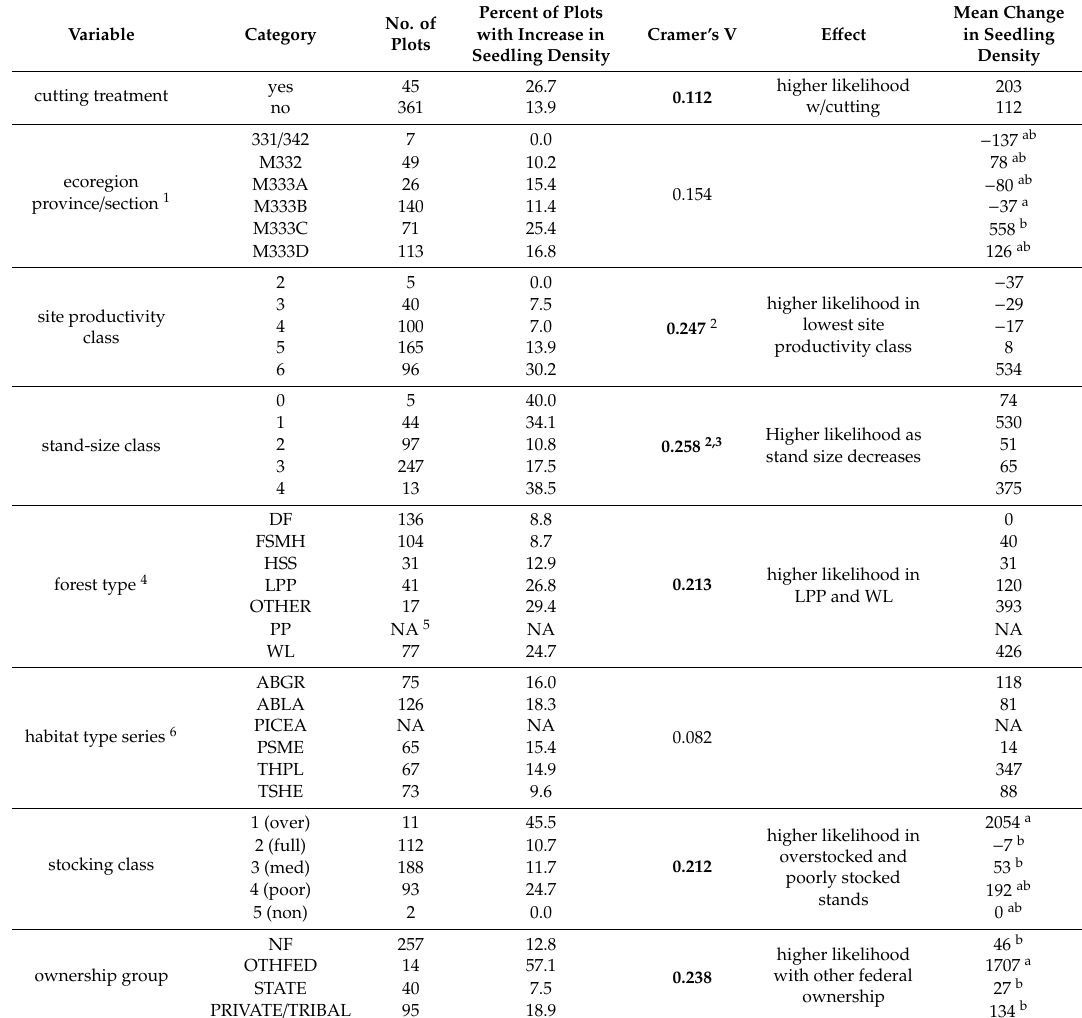
Table A2. Results of analyses of change in western larch seedling density for nine categorical predictor variables. Predictors with significant associations according to Chi-square contingency tests have Cramer’s V scores in bold ( α = 0.05). Levels of predictors with significant di ff erences in seedling density or change in seedling density according to Kruskal-Wallis (for multiple comparison) or Wilcoxon rank sum tests (for single comparisons) are indicated by di ff erent letters next to their median seedling density or mean change in seedling density